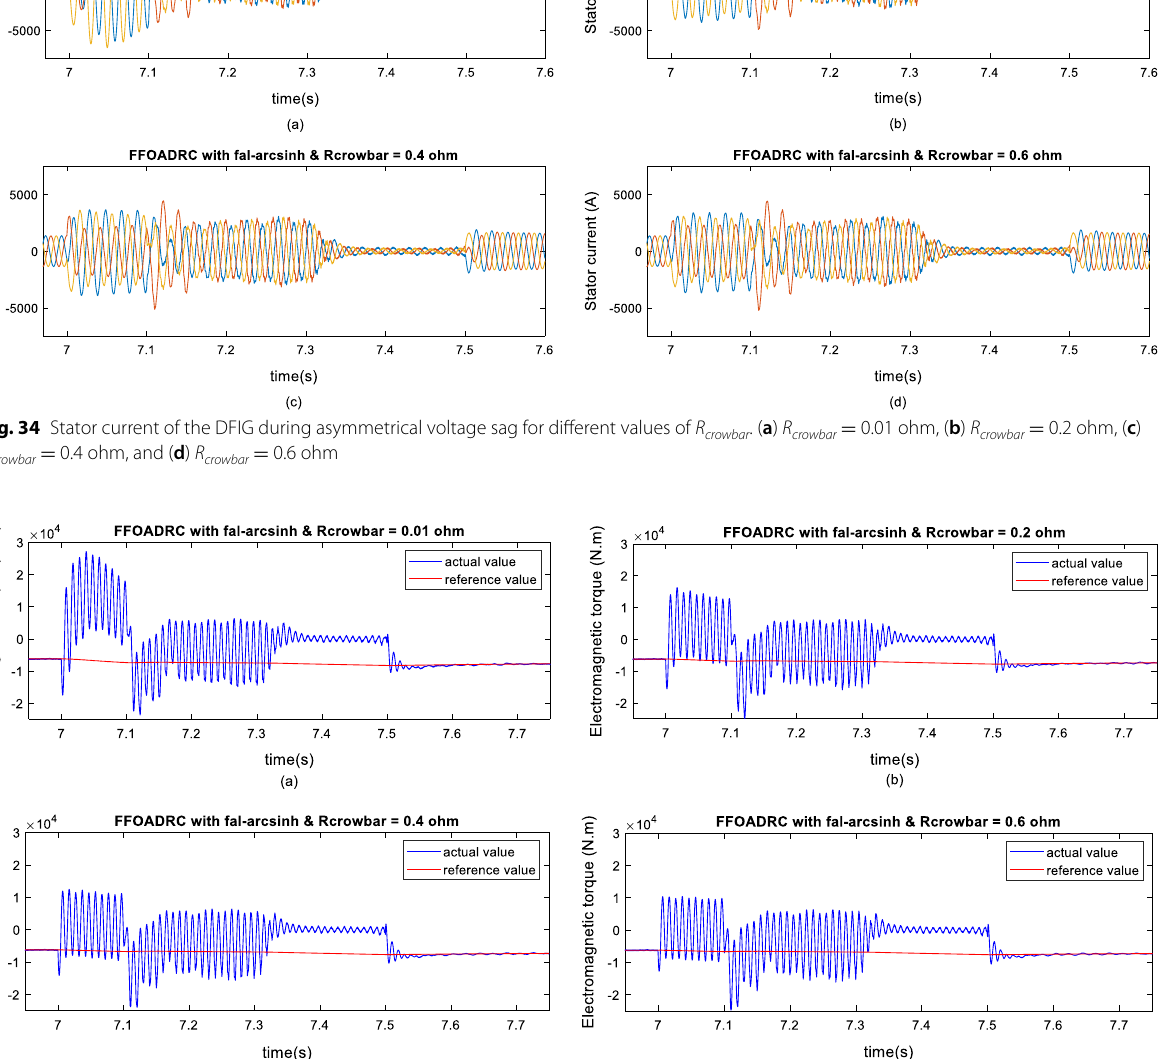
0.01 ohm, ( b ) R crowbar =